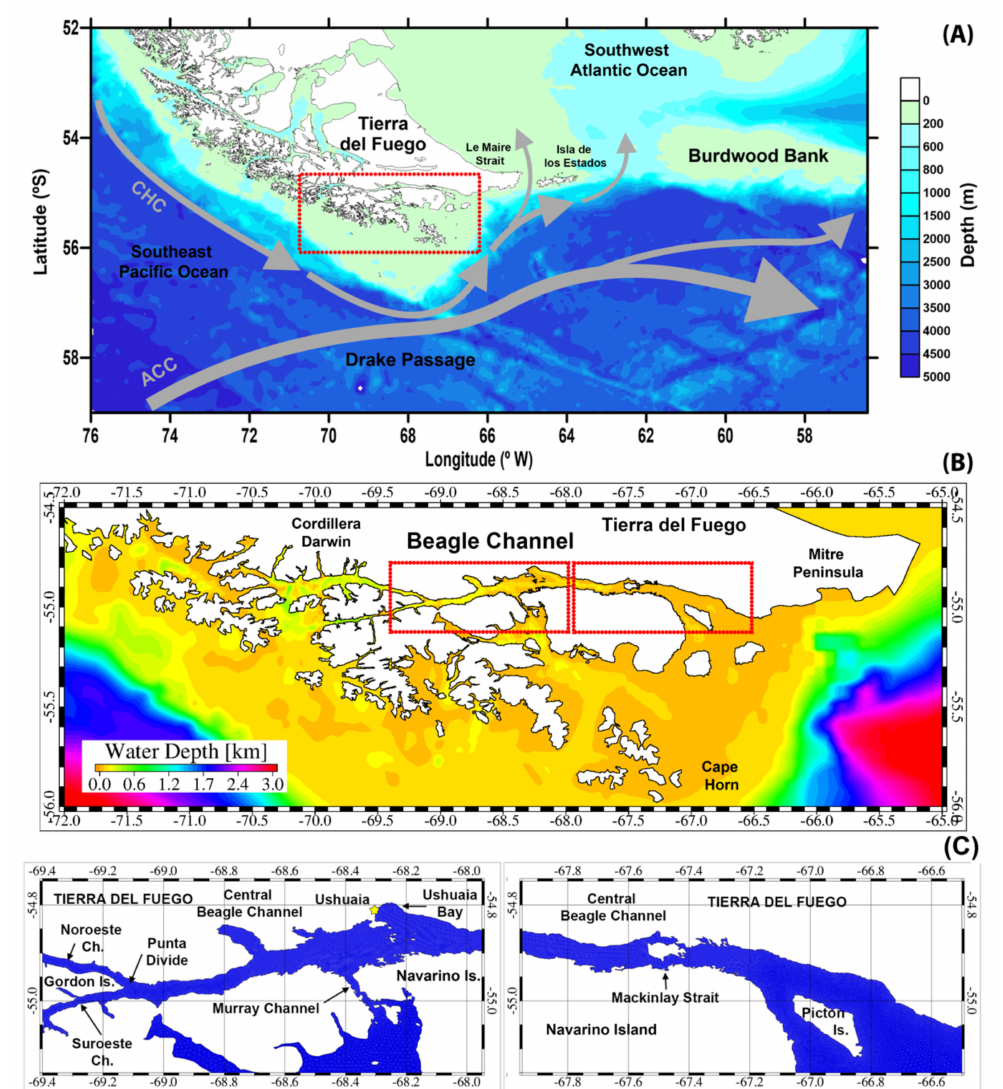
Figure 1. Geographical and oceanographic setting. Southernmost tip of South America showing the Tierra del Fuego Archipelago and Beagle Channel regions within the red box ( A ). Main regional currents are schematized with grey arrows (CHC = Cape Horn Current; ACC = Antarctic Circum- polar Current). The geometry and bathymetry of the Beagle Channel and surrounding islands are magnified in ( B ). ( C ) shows the main geographical locations of the central and eastern sectors of the Beagle